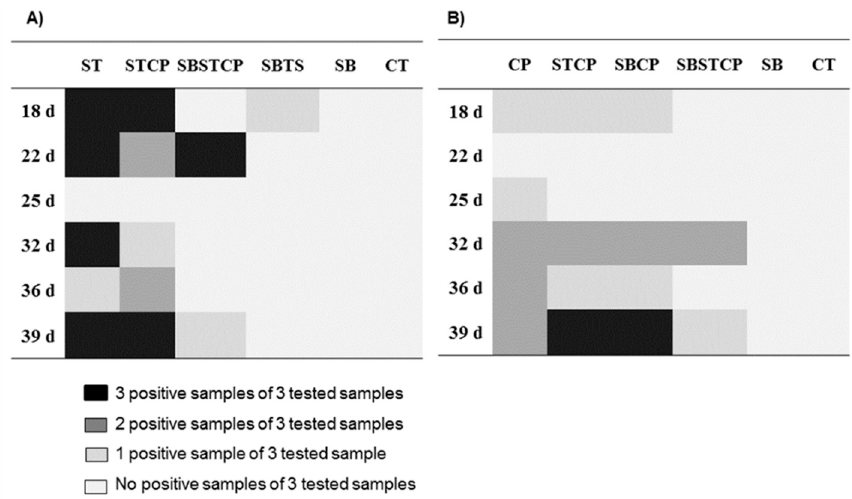
Figure 3. Effect of dietary supplementation with a Synbiotic mix on the isolation of the inoculated Salmonella Typhimurium and Clostridium perfringens from ceca contents of broilers. ( A ) Isolation of the inoculated Salmonella Typhimurium and ( B ) isolation of the inoculated Clostridium perfringens . CT: non-challenged Control group; SB: Synbiotic; SBST: Synbiotic + S. Typhimurium; ST: S. Typhimurium; SBCP: Synbiotic + C. perfringens ; CP: C. perfringens ; SBSTCP: Synbiotic + S. Typhimurium + C. perfringens ; and STCP: S. Typhimurium + C. perfringens.